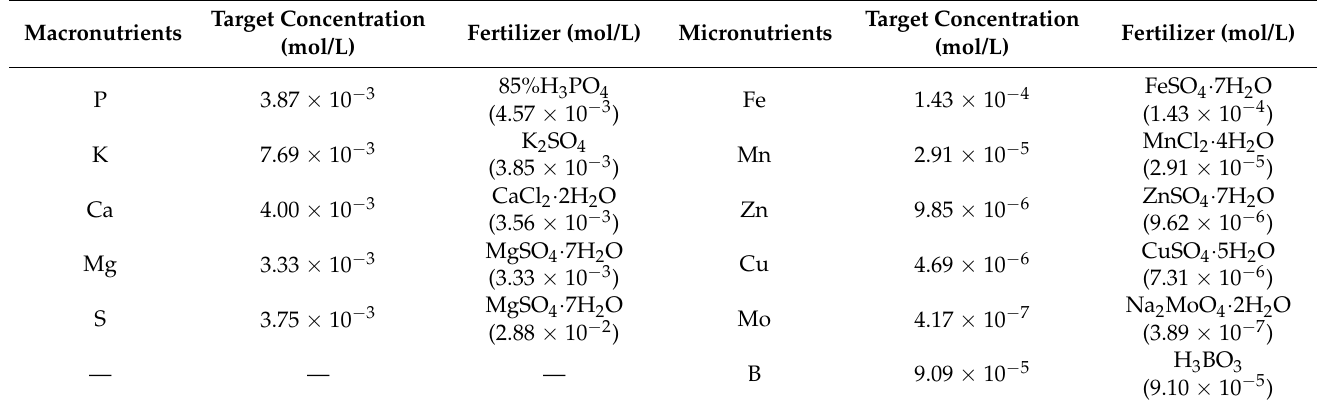
Table 1. The concentration of nutrient elements in nitrogen-free nutrient solution and the configura- tion of